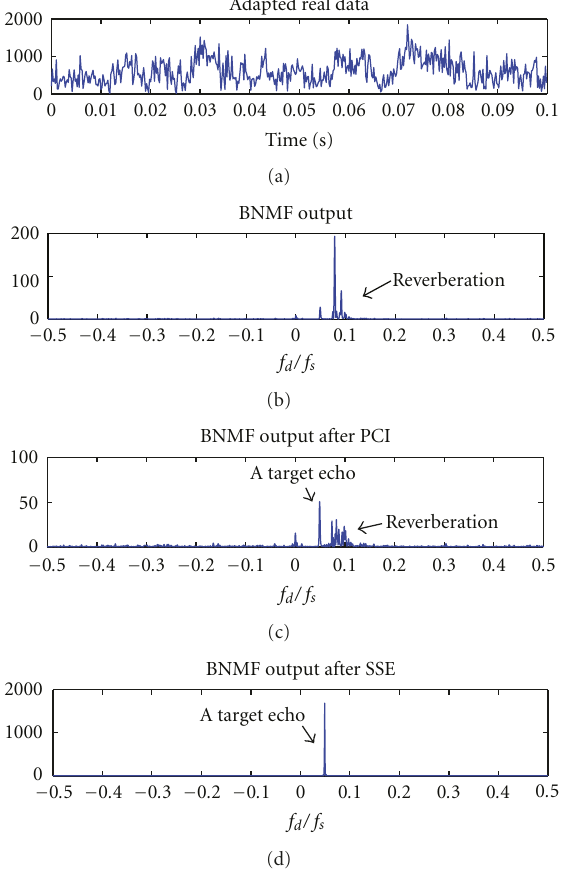
Figure 2: Adapted active sonar data, BNMF outputs without processing, and after PCI and SSE with SSR = − 17 dB, f d / f s = 0 .